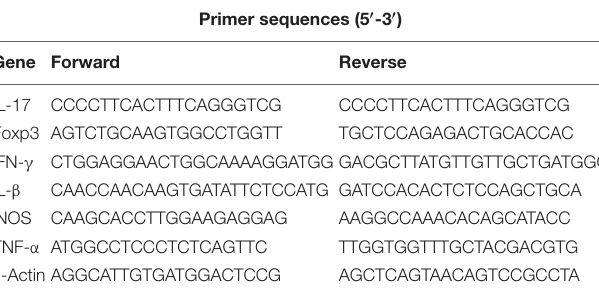
TABLE 1 | Primers used in